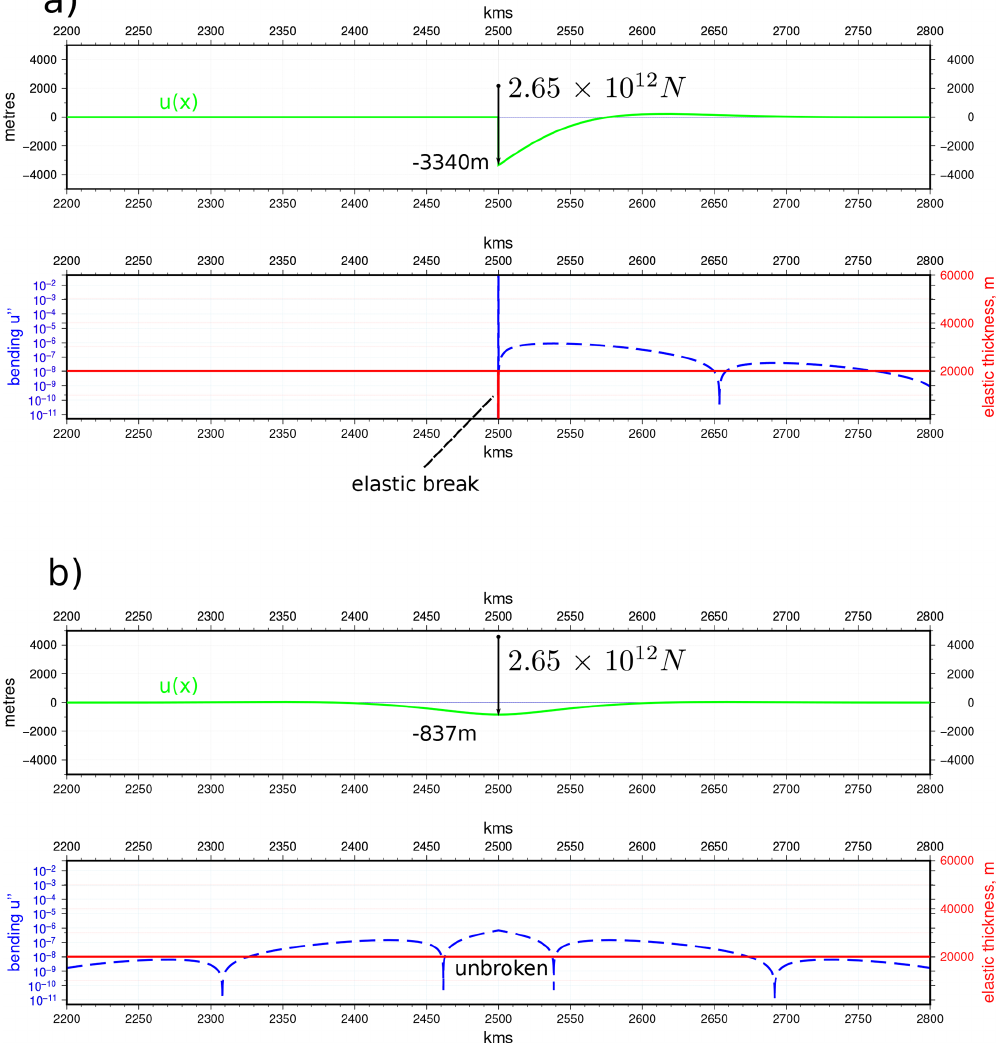
Figure 5. Comparison of broken and unbroken plate loading simulated with “line load” (for parameters used, see Table A1): (a) the “broken” plate contains three node breaks of h = 0 . 01m; (b) continuous plate, same load. The maximum subsidence in ratio ∼ 4 : 1 with a small discrepancy due to the fact that the load is not a true “line” load but rather has a finite width equal to the grid spacing. This exactly corresponds to the analytical results of Gunn (1943b). Figure prepared using GMT v6.0.0 (Wessel et al.,